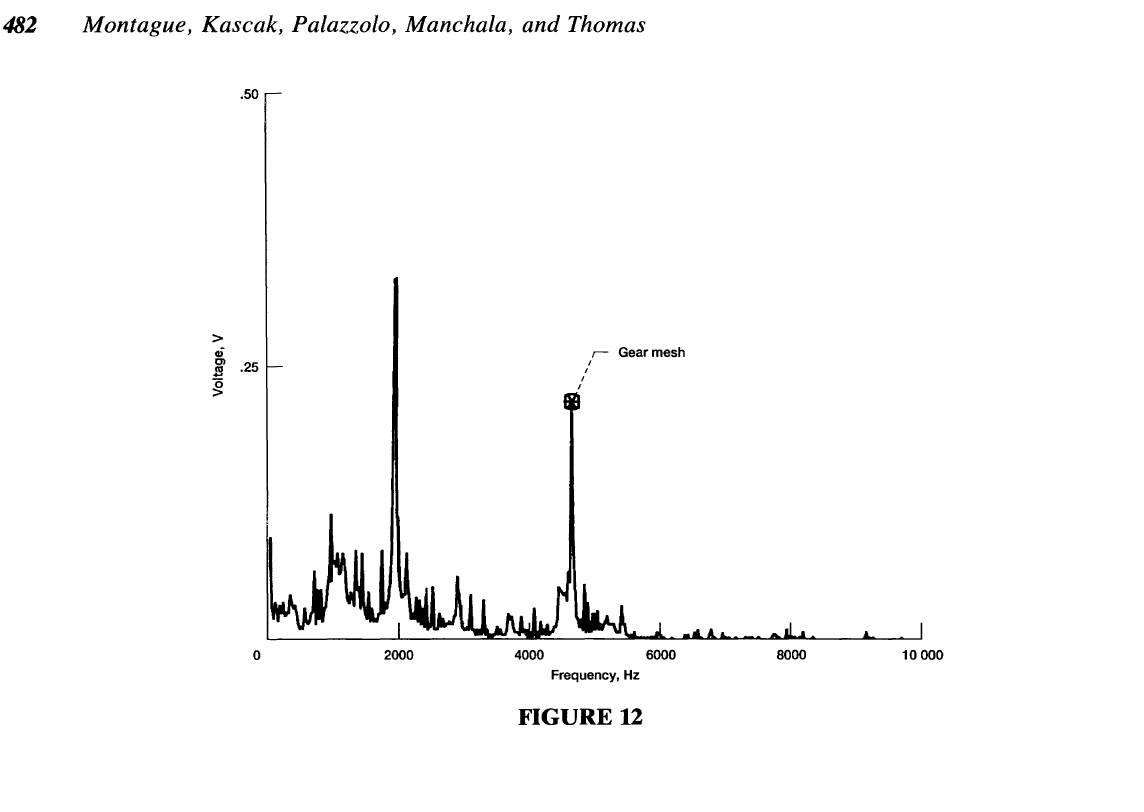
tor system with a + 194-Nm (143-fHb) preload. These results also show very effective vibration control using the feedforward